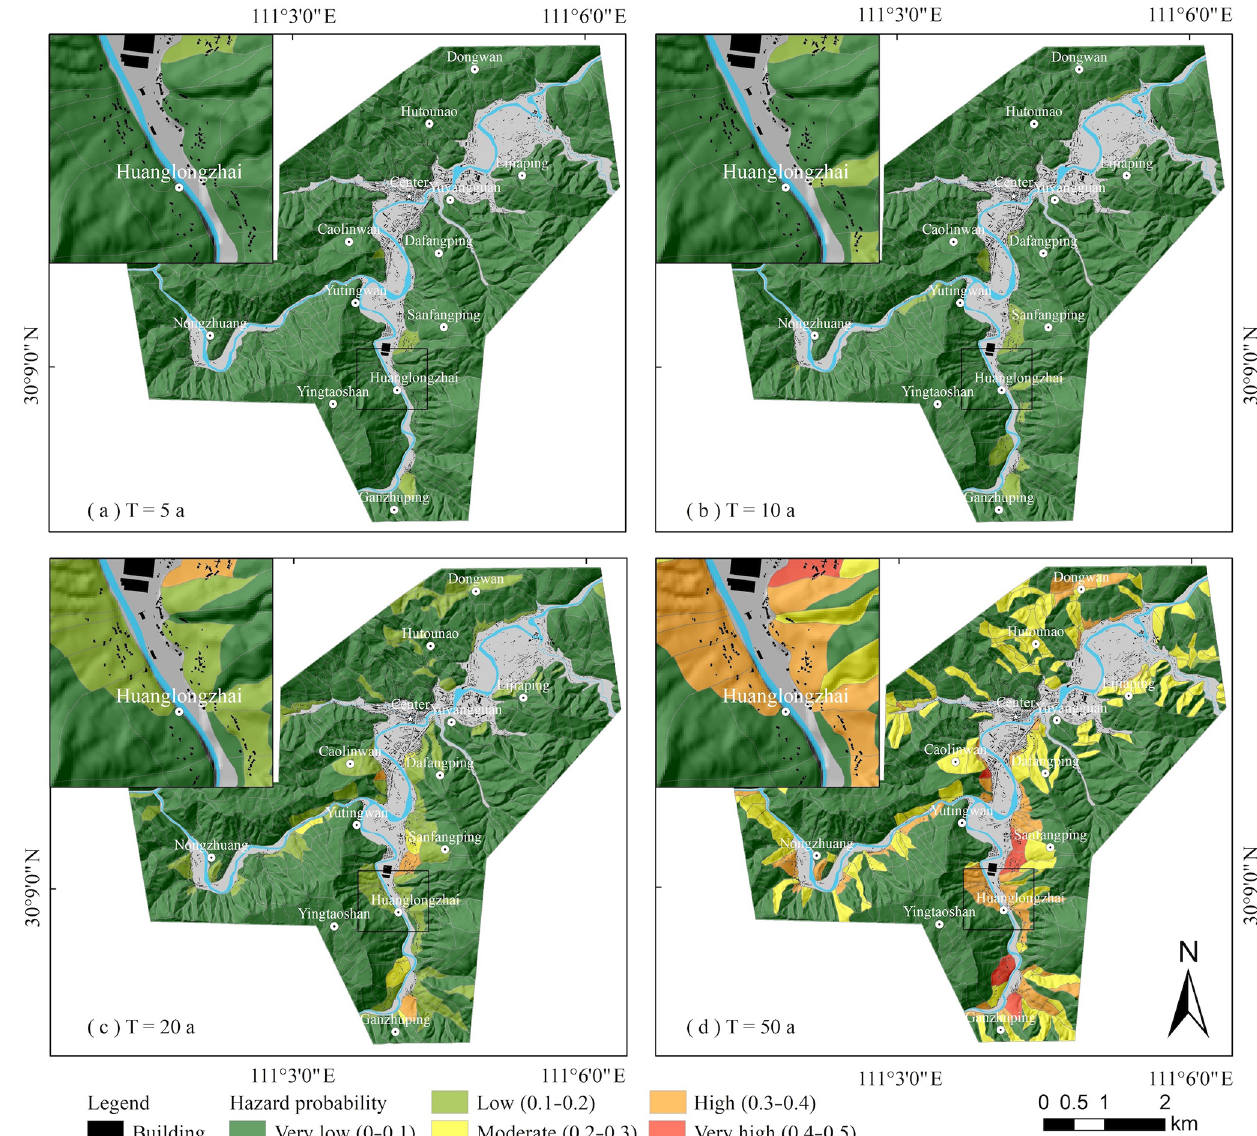
Figure 12. Landslide hazard maps for four return periods (5, 10, 20, and 50 years) and the landslide sizes scenario equal to or greater than 50000m 3 . The maps were generated by integrating the spatial probability in Fig. 8, temporal probability in Fig. 9, and the magnitude– frequency relationships in Fig.